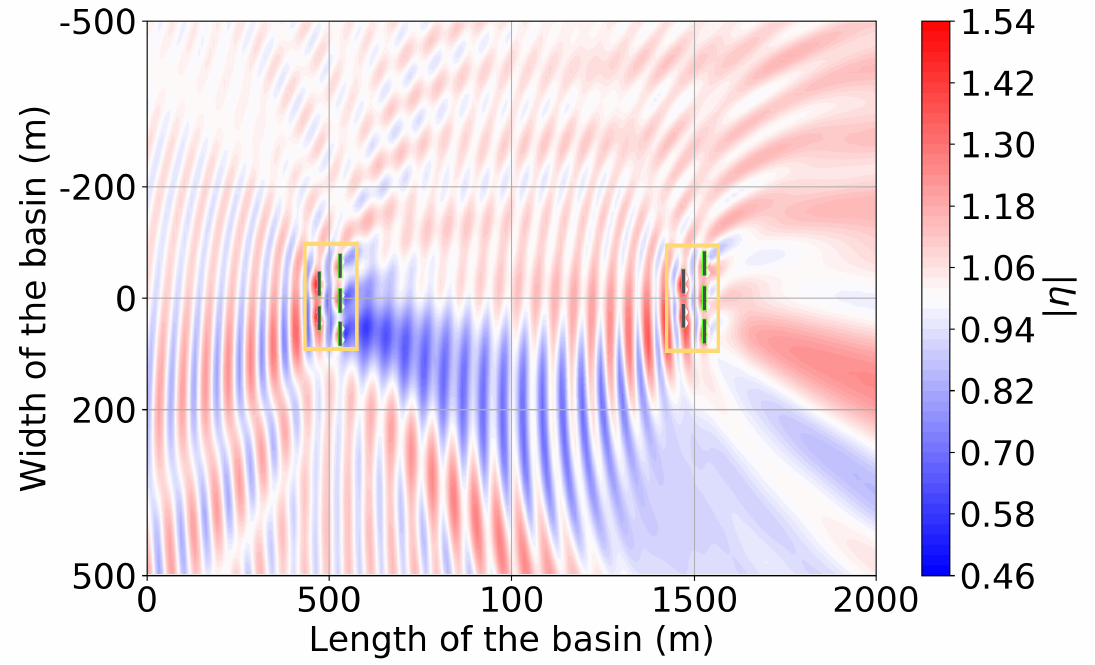
Figure 12. Coupled absolute total wave amplitude | η | for H = 2.0 m , T = 10.0 s and β = − 24 ◦ for a 10 WEC 2-array farm over the sloping bathymetry shown in Figure